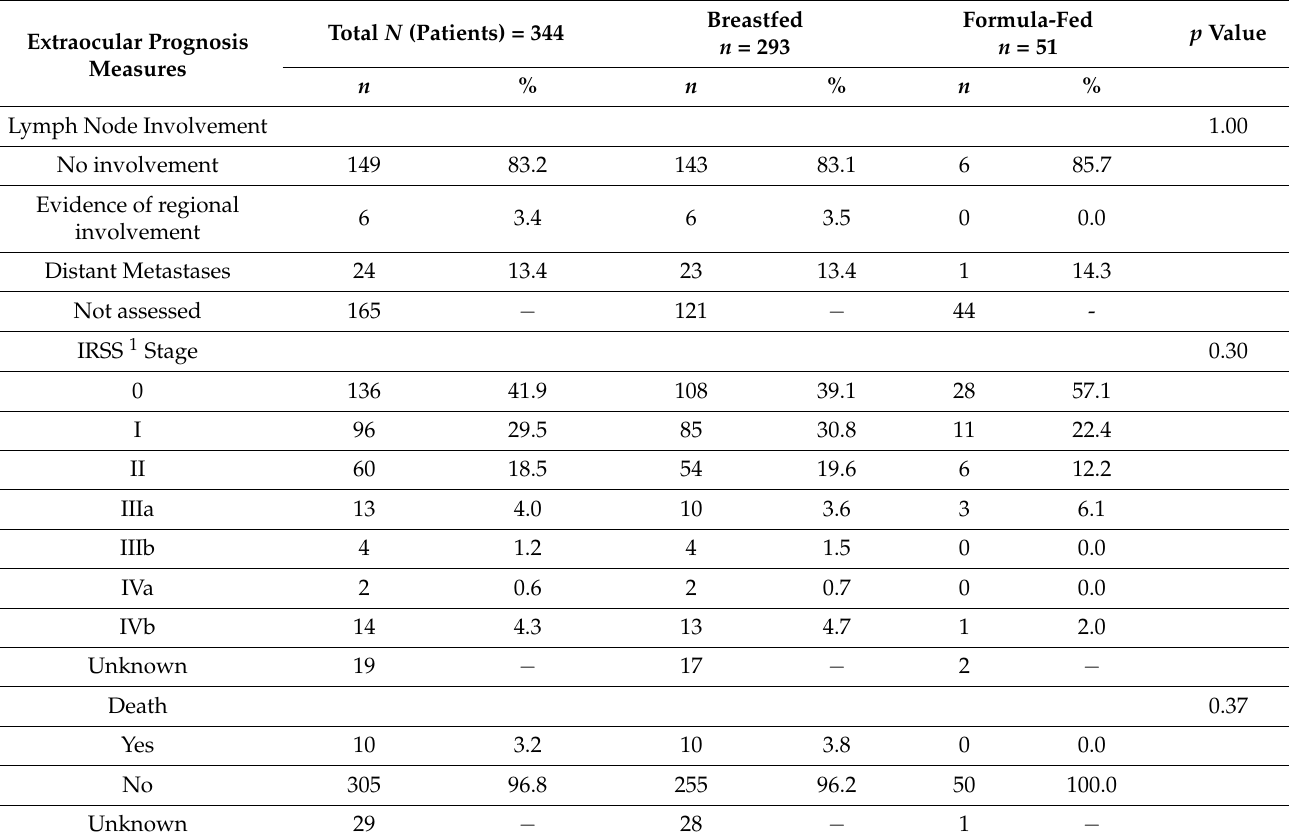
1 Abbreviations: IRSS: International Retinoblastoma Staging